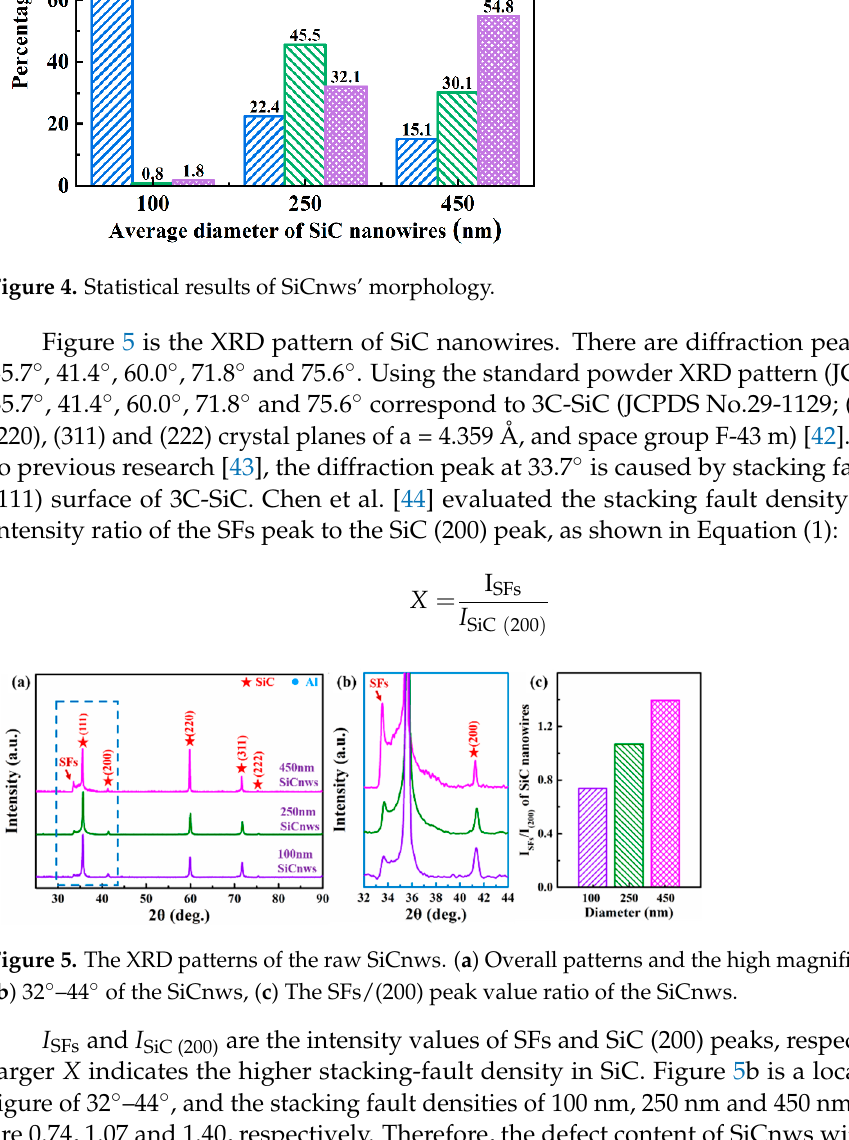
Figure 5. The XRD patterns of the raw SiCnws. ( a ) Overall patterns and the high magnification of the ( b ) 32°–44° of the SiCnws, ( c ) The SFs/(200) peak value ratio of the SiCnws.